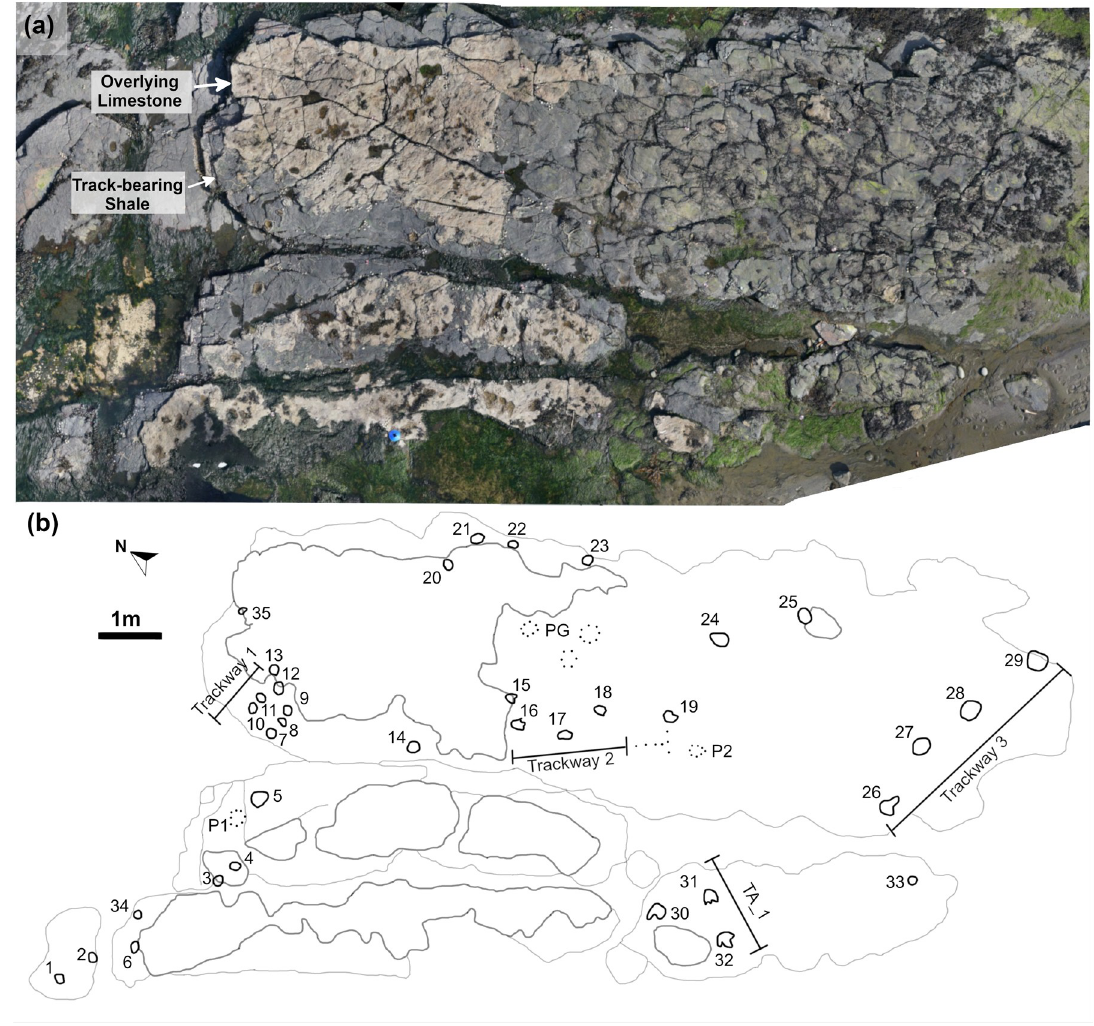
Fig 4. Orthophoto and site map of BP1. (a) The orthophoto for Brother’s Point Site 1 (BP1) strikingly demonstrates the high contrast between the dark gray, track-bearing shale and the overlying and in-filling light tan limestone in the Lonfearn Member of the Lealt Shale Formation. (b) The site map highlights the track distribution spatially and denotes the orientation and length of the trackways relative to one another. Each individual track is labeled with its field number (1–35). P1 and P2 denote ‘possible’ tracks 1 and 2 while PG denotes a ‘possible group’ of shallow impressions. Thick black lines denote the track outlines while lighter lines highlight the contrast between the lithologies and fractures on the outcrop. Dark gray lines delineate the extent of the limestone while lighter gray lines show the platform edges of the shale and some fractures within it. One quadrupedal trackway (Trackway 1; BP1_Twy_01), two bipedal trackways (Trackway 2–3; BP1_Twy_02 –BP1_Twy_03), and one set of associated tracks (TA_1) are present at the